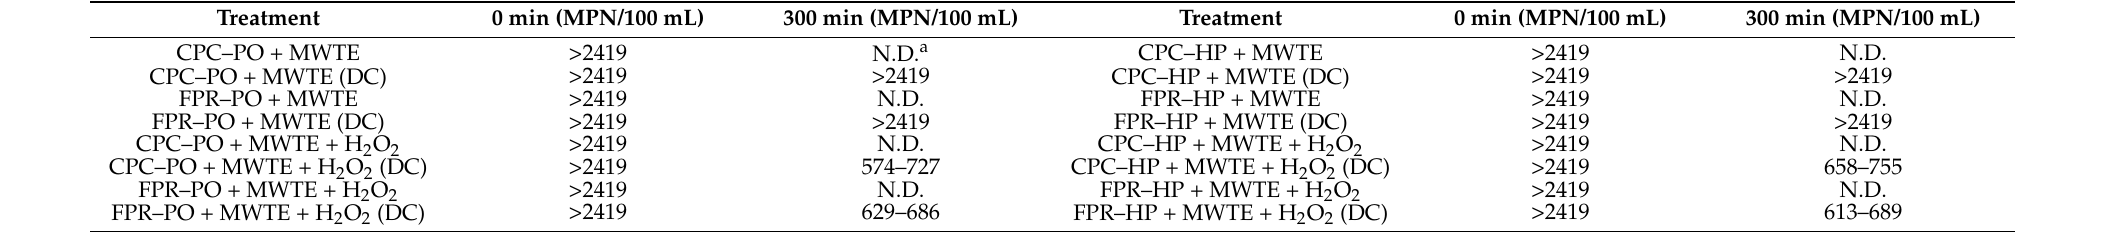
Table 5. Most probable number of coliforms in samples at the beginning and end of each treatment.